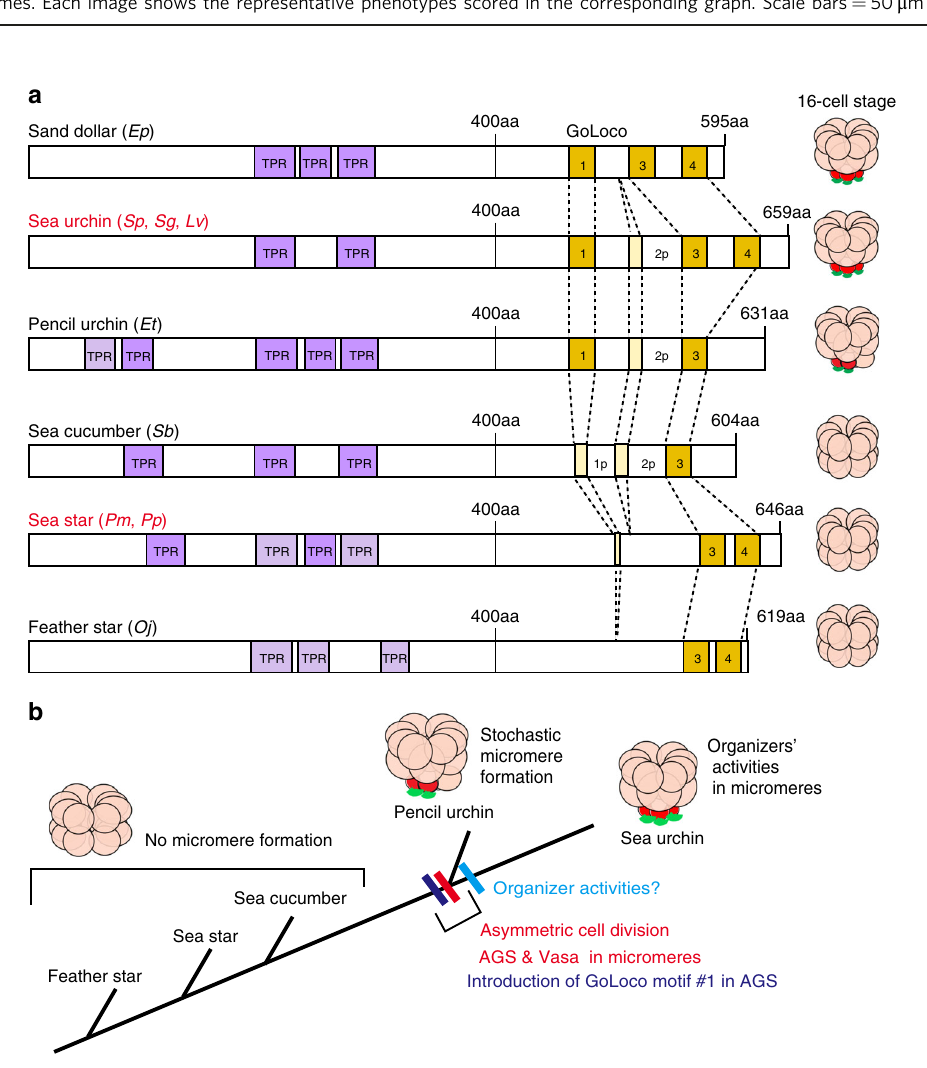
Fig. 9 The evolutionary modi fi cation of AGS proteins among echinoderms. a Predicted motifs of each AGS protein are depicted based on NCBI blast search results (See Supplementary Tables. 6 and 7 for details). Conserved TPR domains are highlighted in purple and GoLoco motifs in yellow (See Supplementary Table 7B for the speci fi c sequence of each GoLoco motif). Less conserved or partial domains are colored in light purple or light yellow, respectively. () indicates species used to construct each cartoon. Vasa, red; AGS, green. b A model for introduction of micromeres during echinoid diversi fi cation. The timing of micromere formation coincides with introduction of GoLoco motif#1 in AGS protein during echinoid diversi fi in part contributed to its distinct cell interactions and develop- mental style among echinoderms (Fig. 9b). This is a mechanism likely used by many cells in various embryos and organisms that acquired new cell types and signaling activities at some point during the course of evolution to establish more rapid, maternally inherited developmental guidance.